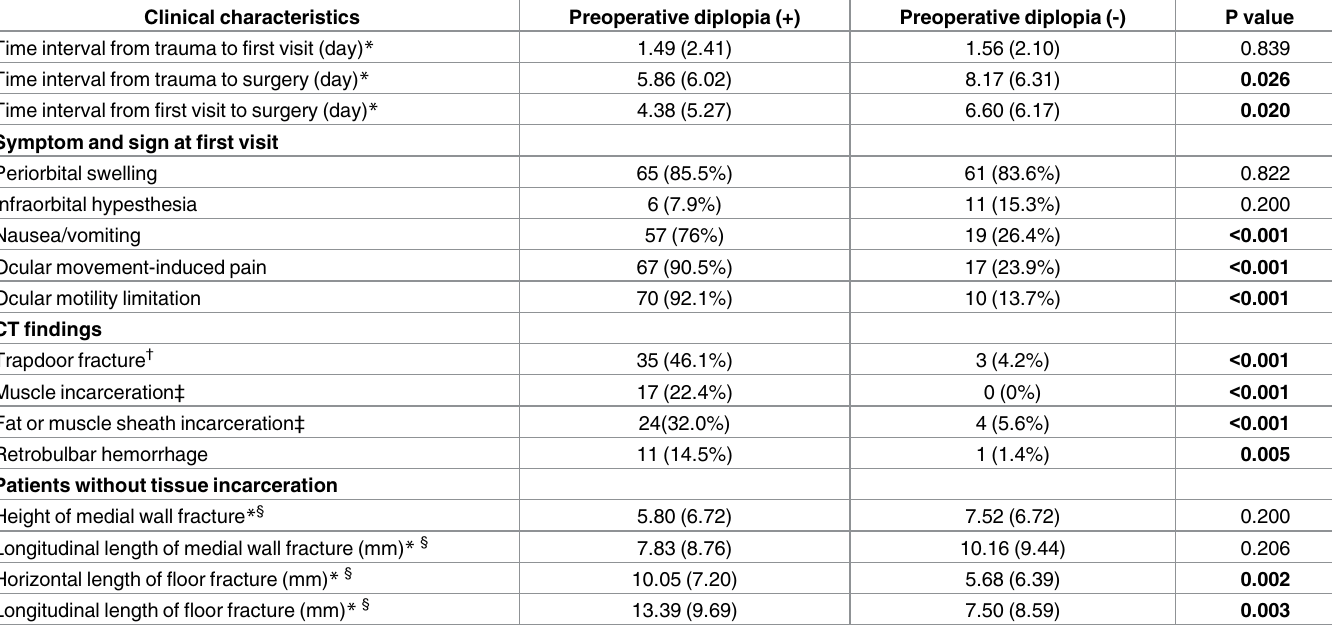
Table 1. Comparison of preoperative characteristics between groups with and without diplopia. Clinical